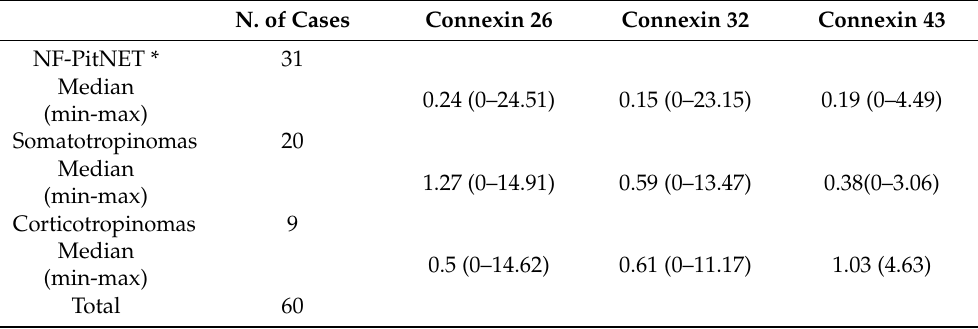
Table 2. mRNA expression levels (2 − ∆∆ Ct ) of connexin 26, 32, and 43 in pituitary neuroendocrine tumors